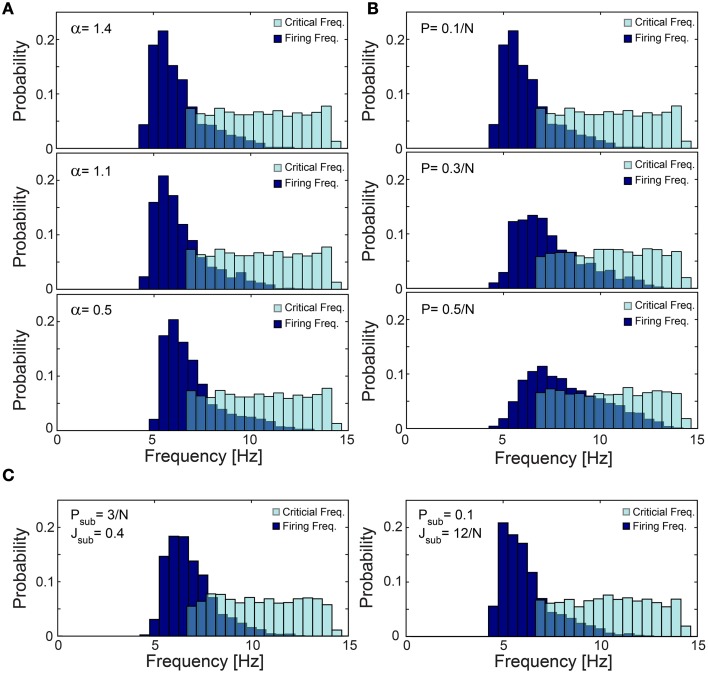
Robustness of low firing rates on a network level. (A–C) The normalized histogram of critical frequency, fC (light blue), and firing frequency (dark blue). (A) The low firing activity is robust to variations in α. An identical network topology as in Figure 11C but with different α: 1.4 (upper panel), 1.1 (middle panel) and 0.5 (lower panel), with mean firing rate of 6.26, 6.43, and 6.96 Hz, respectively. (B) The low firing activity is robust to higher connectivity. Networks obeying the same statistical features as in Figure 11C but the probability for an additional above-threshold connection, P, (see Materials and Methods) is 0.1/N (upper panel), 0.3/N (middle panel), and 0.5/N (lower panel), with mean firing rate of 6.26, 7.43, and 8.23 Hz, respectively. Results indicate that higher connectivity slightly increases the firing rates. (C) The low firing activity is robust to additional sparse/dense sub-threshold connectivity. Networks obeying the same statistical features as in Figure 11C where each neuron has, on the average, additional N·Psub = 3 (left panel), 0.1·N (right panel) sub-threshold post-synaptic connections with the strength of Jsub = 0.4 (left panel), 12/N (right panel). Note that the average total strength of the sub-threshold connections, per neuron, is preserved for both sparse and dense cases as N·Psub·Jsub = 1.2. All the results shown in this figure were produced in simulations.